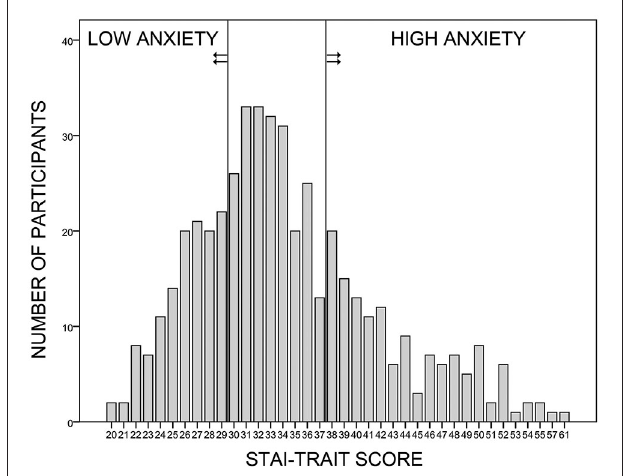
FIGURE 1 | Sample selection . Four hundred and seventy-seven female volunteers participated in the online survey, in which they answered to the trait anxiety form of the German Spielberger State-Trait-Anxiety-Inventory (STAI; Laux et al., 1981) and to the Self-Rating Questionnaire on Hypersensitivity to Sound (GÜF; Nelting et al., 2002). Women with a trait anxiety score within the lowest or the highest quartile of the sample were recruited for the low and high anxiety groups, respectively. All participants had a GÜF score below 11 (not shown